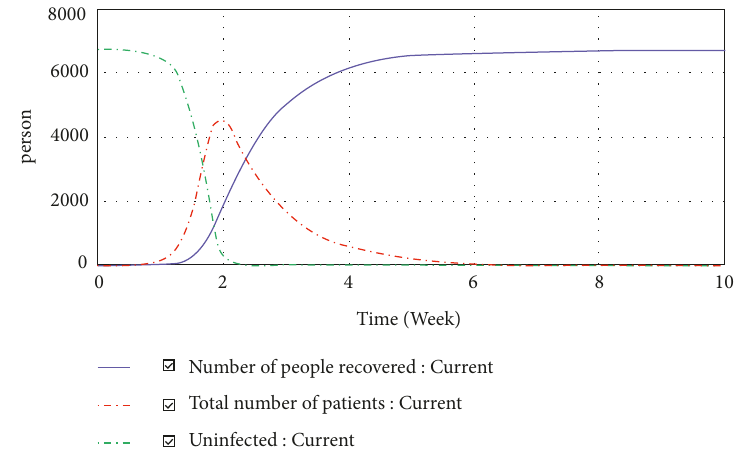
Figure 6: Simulation results of an infection evolving in the second stage.